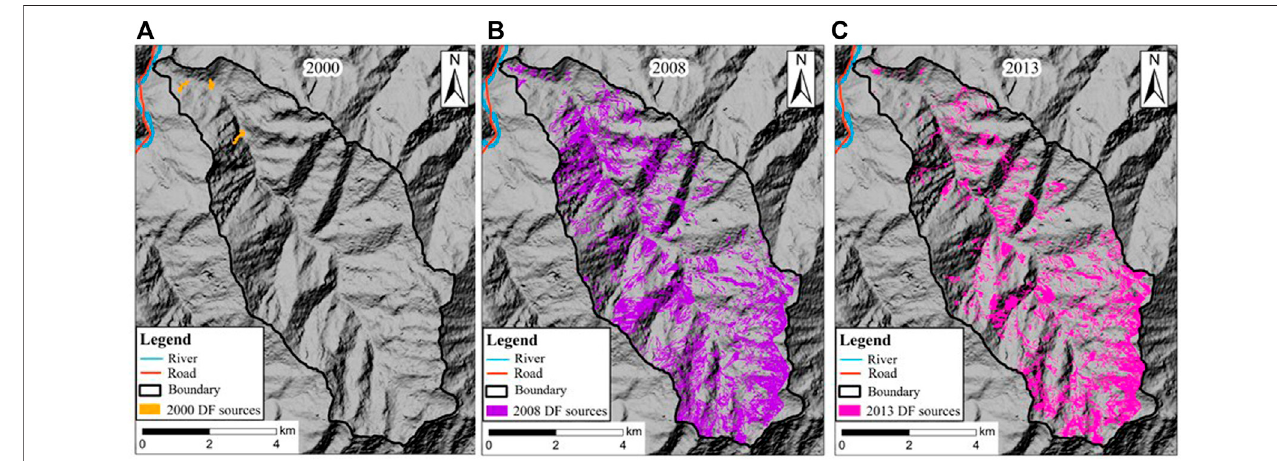
FIGURE 5 | Distribution of loose source materials for debris fl ows. (A) Debris fl ow sources in 2000, prior to the 2008 Wenchuan Earthquake. (B) Debris fl ow sources in 2008, just after the earthquake. (C) Debris fl ow sources in 2013, after a catastrophic debris fl ow.